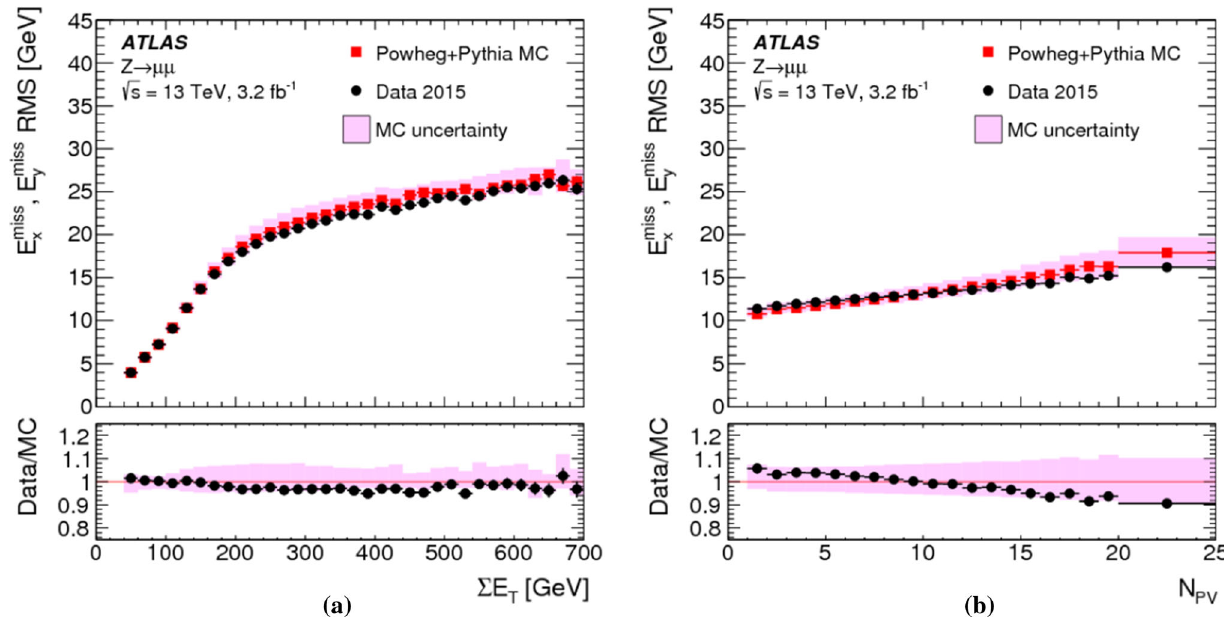
Fig. 7 The RMS width of the E miss distributions a in bins of (cid:10) E T the data points, and the ratios are shown below the respective plot. The x ( y ) shaded bands indicate the combined statistical and systematic uncer- and b in bins of the number of primary vertices in an inclusive sample tainties of the resolution of Z → μμ events. Predictions from MC simulations are overlaid on